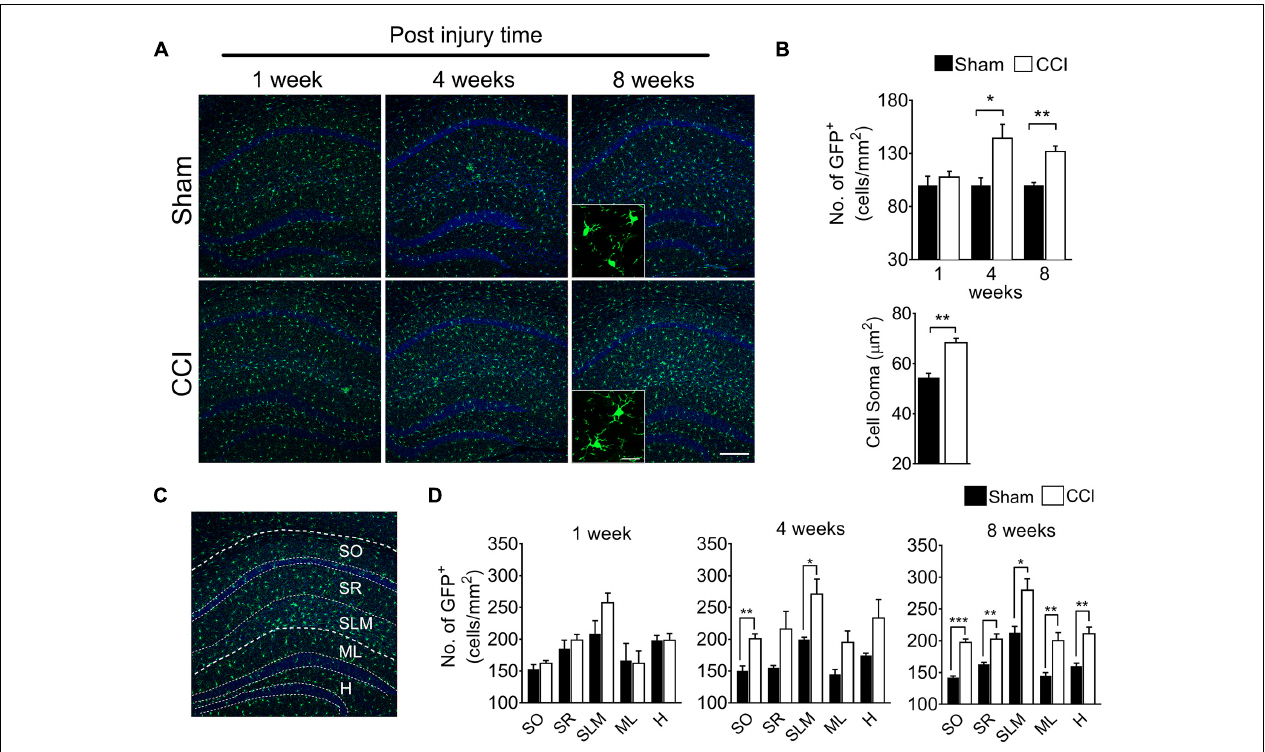
FIGURE 3 | CCI-induced mice showed altered microglial morphology in hippocampal layers at delayed time points. (A) Representative images of the hippocampus and images taken at 1, 4, and 8 weeks post-injury under high magnification (inset) are shown. (B) Microglial cell number in the hippocampus shows significant increases at 4 and 8 weeks ( n = 5, 3–4 tissue sections per animal, mean ± SEM, ∗ p < 0.05, ∗∗ p < 0.01) along with significant increases of the microglia soma area ( n = 5, 3–4 tissue samples per section, 40 microglial cells, mean ± SEM, ∗∗ p < 0.01). (C) Hippocampal layers, namely the stratum oriens (SO), stratum lacunosum moleculare (SLM), molecular layer (ML), and hilus (H) were demonstrated. (D) Hippocampal layer-specific microglial cell numbers were assessed at 1, 4, and 8 weeks post-injury and demonstrated significant differences in the CCI group compared to the sham group ( n = 5, 3–4 tissue sections per animal, mean ± SEM, ∗ p < 0.05, ∗∗ p < 0.01, ∗∗∗ p < 0.001). Scale bar: 100 µ m. Inset scale bar: 100 µ